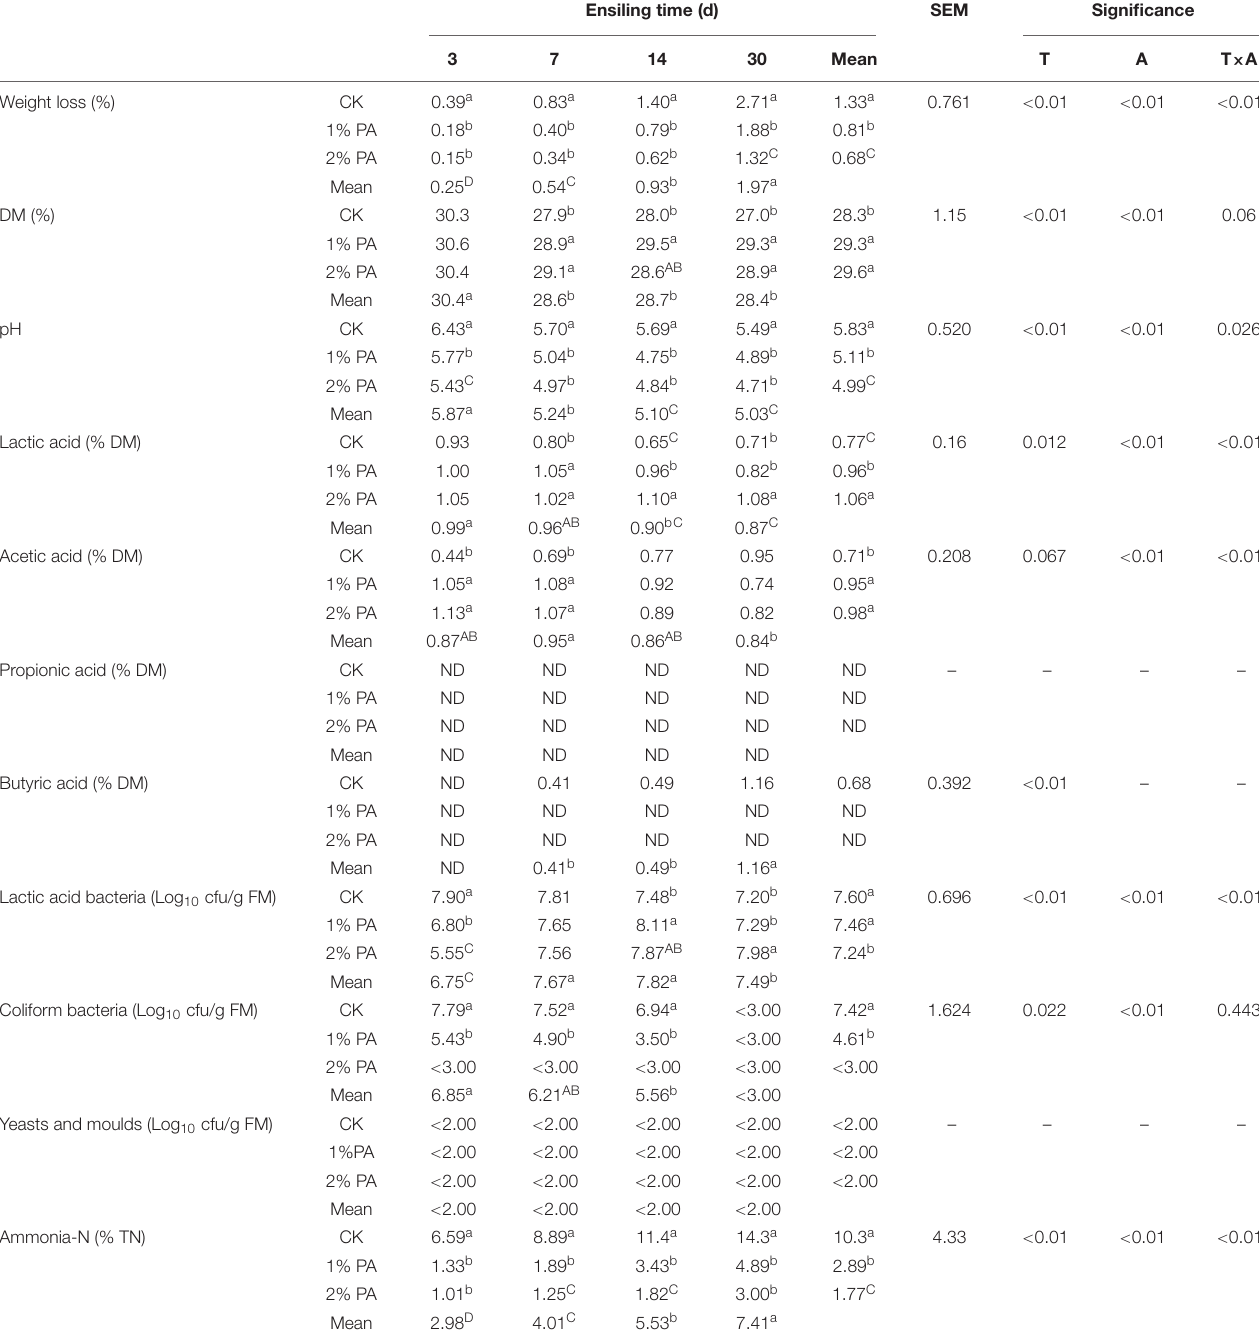
Ensiling time (d)